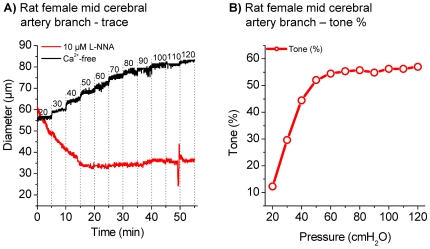
Diameter and myogenic tone in female rat mid-cerebral artery territory branch.Original trace of female rat mid-cerebral artery territory branch in 10 µM L-NNA and Ca2+-free solution (A). Calculated myogenic tone in %, n = 1 (B).